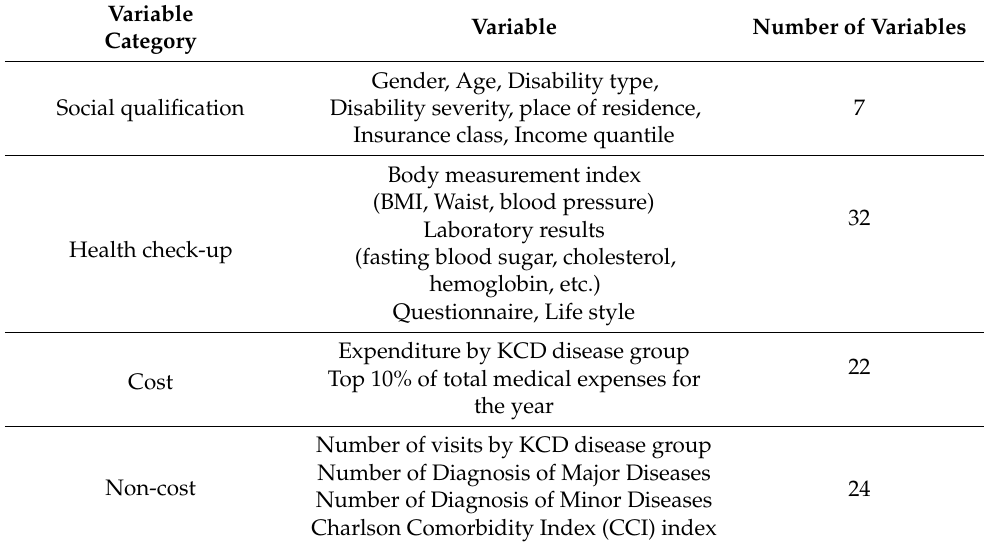
Table 4. Description used dataset variables by category.